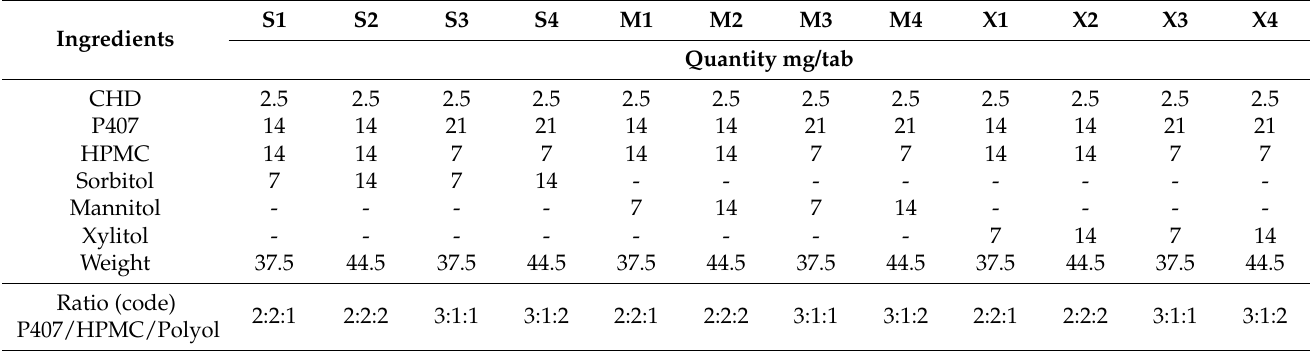
Table 1. Composition of CHD mucoadhesive buccal